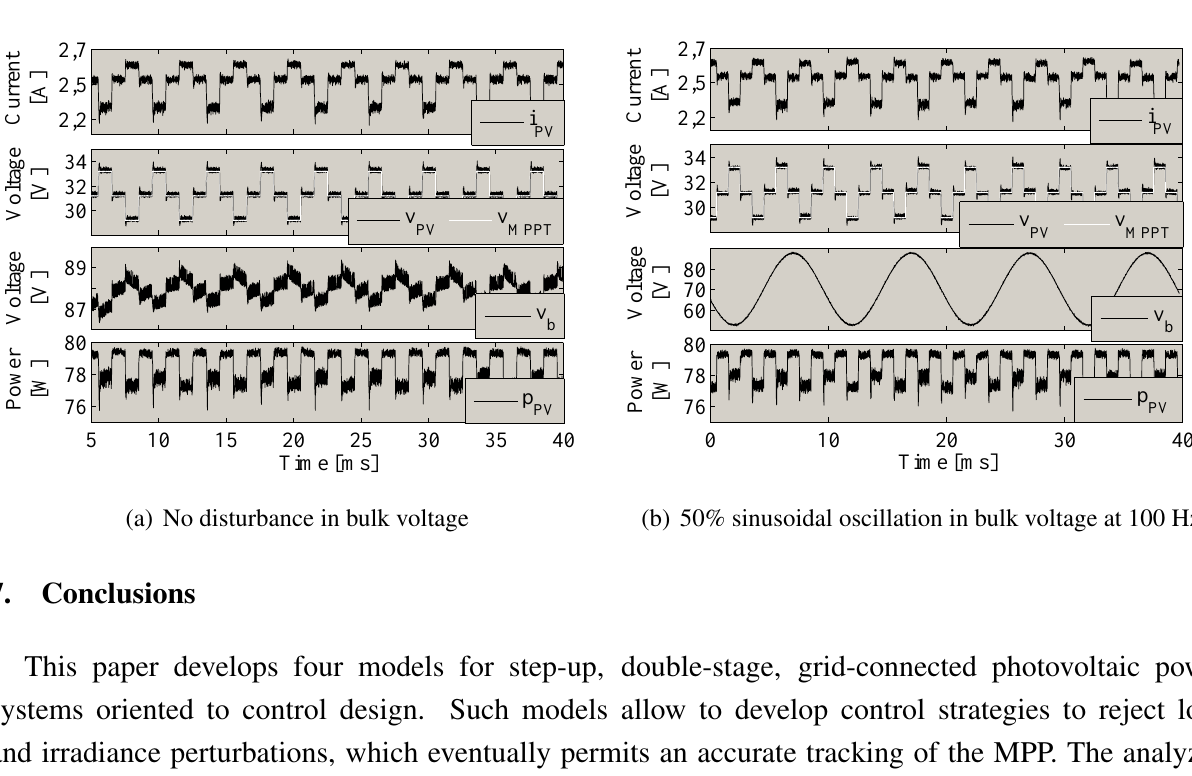
Figure 19. Experimental